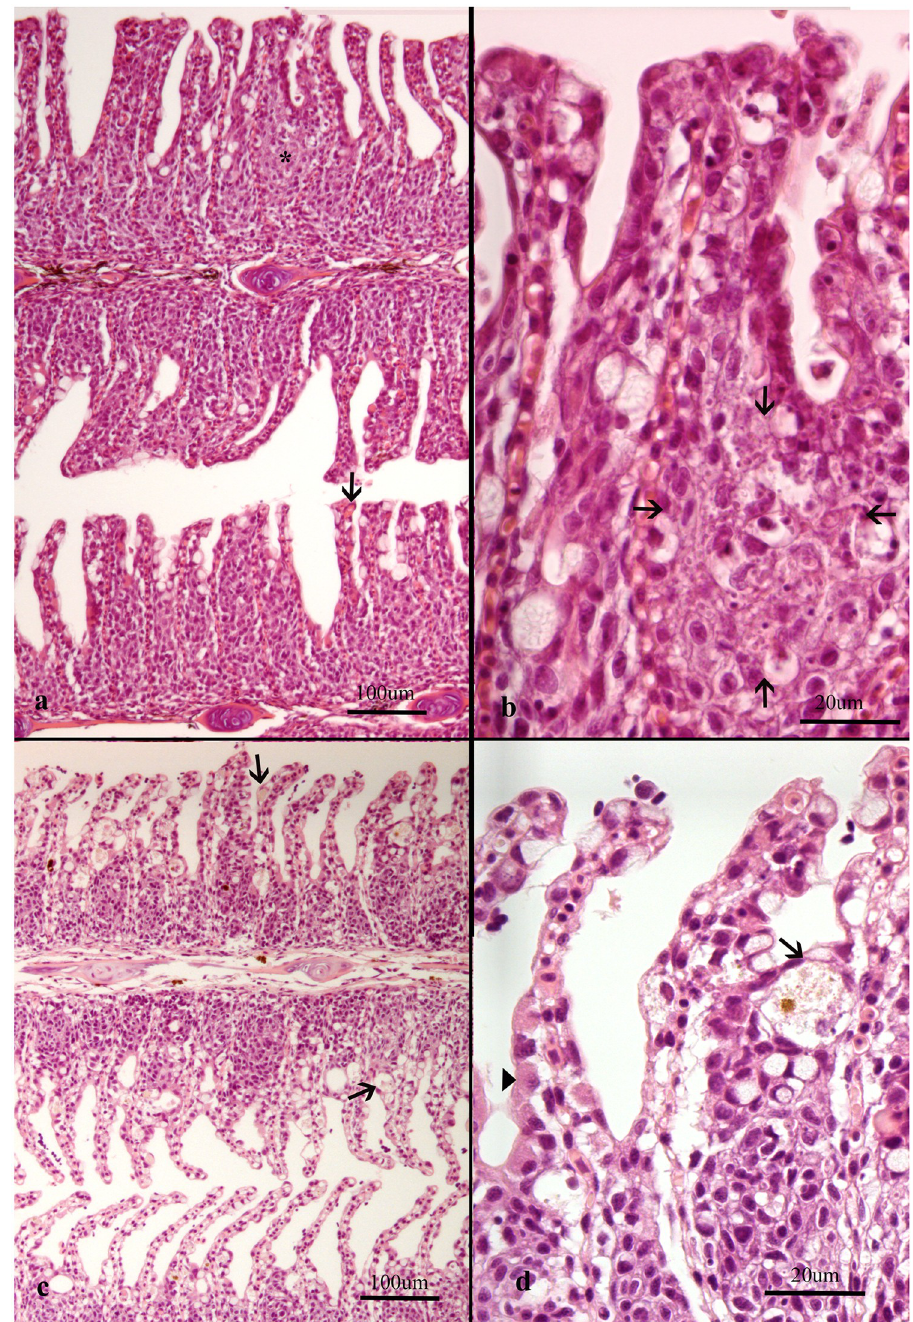
Fig 2. Histological sections of gills from Atlantic salmon. Note that plane of section is consistently on the efferent side of the gills in all images as judged by the small amount of filament cartilage. (a-b) Gills from farm 13 were dominated by Desmozoon lepeoptherii and Ca . Branchiomonas cysticola. (a) Epithelial cell hyperplasia scored 6, some thrombosis (arrowhead) and necrosis in hyperplastic lesions (arrow) scored 5, an area enlarged in (b) (arrows). (c-d) Gills from farm 3 were dominated by Ca . Branchiomonas cysticola and Desmozoon lepeoptherii . (c) Epithelial cell hyperplasia scored 4, ballooning degenerative cells containing pigmented material (arrows), scored 6. (d) Enlarged area from c with chloride cell hyperplasia (arrowhead) and ballooning degenerative cells containing pigmented material (arrow).